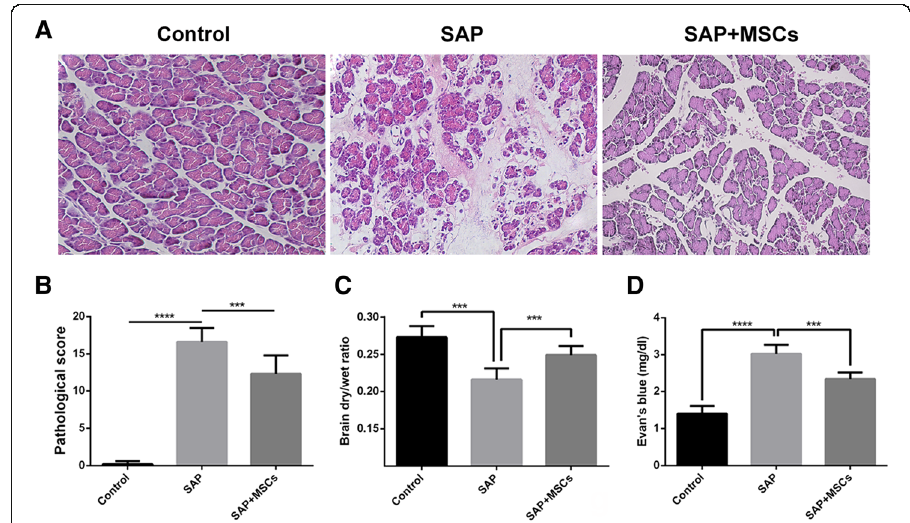
Fig. 2 MSCs alleviated pancreatic impairment and decreased BBB permeability in SAP rats. a H&E staining of the pancreas (× 200). No obvious pathological changes were observed in the control group, while edema, hemorrhage, necrotic acini and the infiltration of inflammatory cells were observed in the SAP group. The pancreatic impairment in the SAP+MSCs group was milder than that in the SAP group. b Pancreatic pathological scores. c Brain dry/wet ratio calculation. d The results of the Evans Blue assay. *** p < 0.001, **** p <